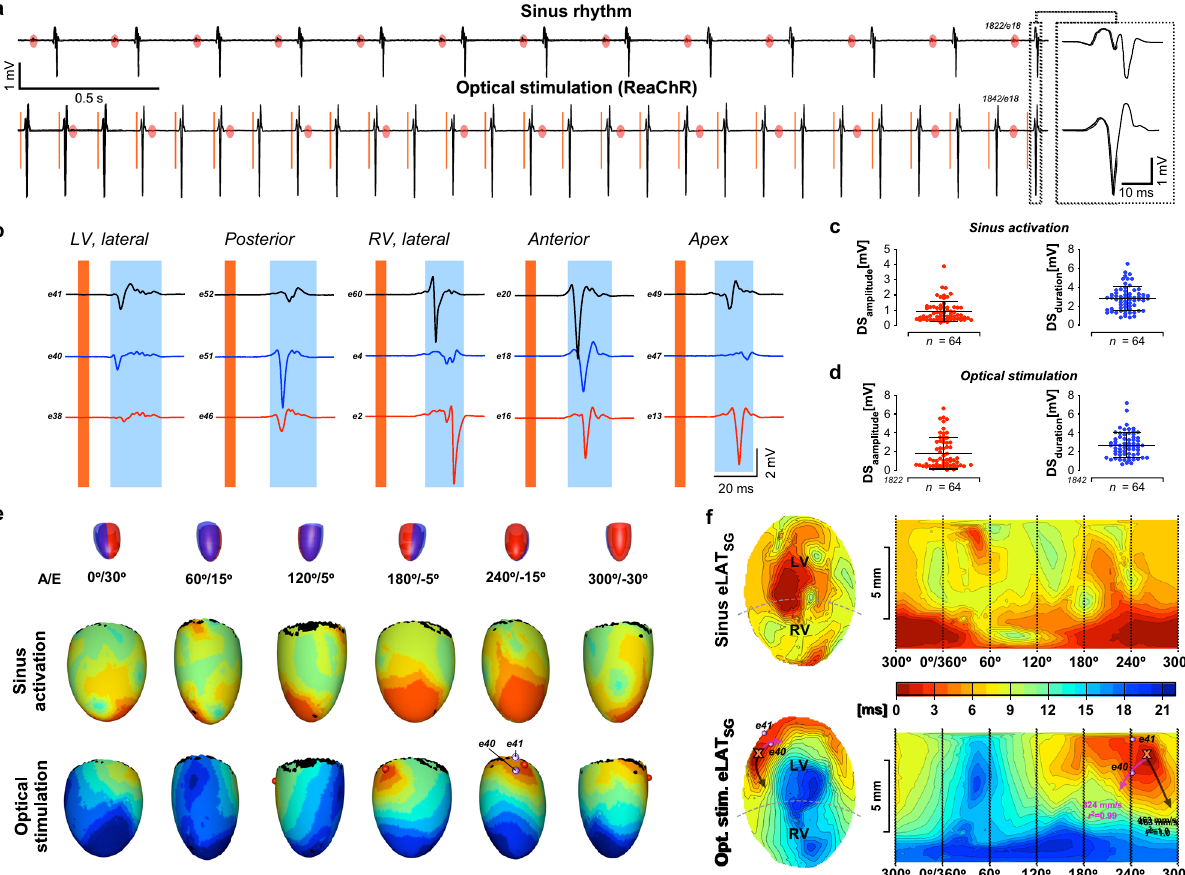
Fig. 5 Single fi ber optical stimulation of a Myh6-Cre Tg /ReaChR lox/wt heart. a Local unipolar electrograms during sinus rhythm (upper trace; red ovals: atrial activations) and during optical stimulation (lower trace; identical recording site; orange lines: optical stimulation). The last electrogram is shown in expanded form on the right. b Selection of electrograms recorded at different sites (LV: left ventricle; RV: right ventricle) after optical stimulation (stimulation: orange band; local electrograms: blue bands). c Electrogram downstroke (DS) amplitudes and durations recorded during sinus rhythm and, d during optical stimulation. e Schematic drawings of heart orientation (A: angle; E: elevation; red: left ventricle; blue: right ventricle) with corresponding 3D maps of sinus driven ventricular activation (top) and optically stimulated activation (bottom; red sphere: site of optical stimulation; violet spheres: recording electrodes close to the stimulation site with signals shown in panel b). f Central- and Mercator projections of electrically determined ventricular activation (eLAT SG ) during sinus rhythm (top) and following optical stimulation (bottom; orange cross: optical stimulation site; violet spheres: electrodes; black arrow: direction of fastest activation; red arrow: propagation in perpendicular direction; arrow lengths are scaled to conduction velocities). “ n ” refers to the number of signals produced by the recording sites during a single activation of the heart. Error bars refer to ±SD. Source data are provided as a Source Data fi (3.09 ± 1.98 mV, n = 62; Fig. 4g) and durations (2.79 ± 1.11 ms; using a single fi ber delivering 5 ms long pulses of excitatory light Fig. 4h) similar to those recorded from ArcLight-Q239 expressing (590 nm) with a total power of 1.7 mW (8.8 mW/mm 2 ). Suc- cessful optical overdrive pacing at 7 Hz is demonstrated by con- hearts. From the stimulation site, excitation spread uniformly stant intervals between the optical pulse (orange line) and the across the ventricles with electrical and optical activation patterns fi eld potential reported by a single electrode (Fig. 5a, lower trace). being highly similar as demonstrated by the small oLAT SG - eLAT SG difference of 0.35 ± 1.50 ms ( n = 58; Fig. 4i, j; for The expanded view of electrograms acquired by the same elec- trode during sinus rhythm and during optical stimulation shows a animation cf. Supplementary Movie 3). The central- and change of shape during optical stimulation which is likely Mercator projections shown in Fig. 4k illustrate that maximal explained by the concomitant change in activation direction. The conduction velocities determined by either measurement mod- comparison of electrogram parameters determined during optical ality were comparable ( θ o : 567 mm/s; θ e : 750 mm/s) as were anisotropy ratios (optical: 1.33; electrical: 1.34) and overall stimulation and sinus rhythm (Fig. 5c, d) shows similar down- activation times (optical: 16.0 ms; electrical: 16.7 ms). stroke times (2.79 ± 1.28 ms vs. 2.74 ± 1.32 ms, n = 64), whereas downstroke amplitudes were substantially larger during optical stimulation (1.84 ± 1.64 mV vs. 0.91 ± 0.68 mV, n = 64). The 3D Single- fi ber optical stimulation of a heart expressing the activation maps shown in Fig. 5e demonstrate initiation of acti- optogenetic membrane voltage actuator ReaChR . Optical sti- vation at the optical stimulation site from where it invaded the mulation capabilities of the POEMS system were validated with ventricles with the basal regions of the lateral right ventricle being hearts of Myh6-Cre Tg /ReaChRr lox/wt mice. After control record- excited last (for animation cf. Supplementary Movie 4). Overall ings in presence of sinus rhythm (Fig. 5a, upper panel; atrial ventricular activation took 11.6 ms (sinus rhythm) and 20.9 ms activity indicated by red ovals), the heart was optically stimulated